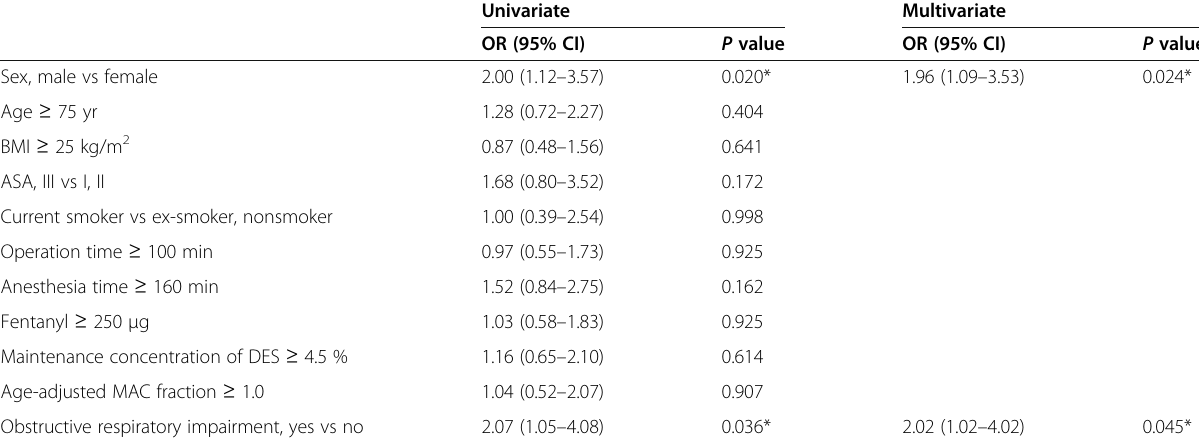
Table 4 Univariate and multivariate Cox regression models predicting prolonged extubation time Univariate